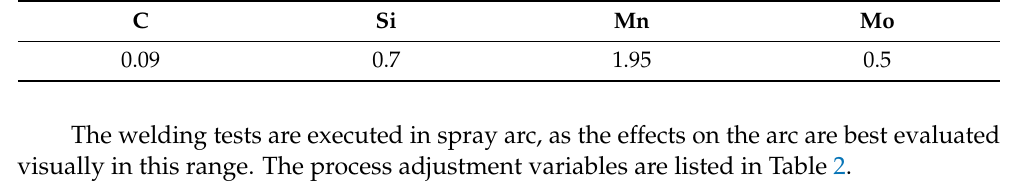
Table 1. Chemical composition DIN EN ISO 14341-A G 50 7 M21 4Mo [23].